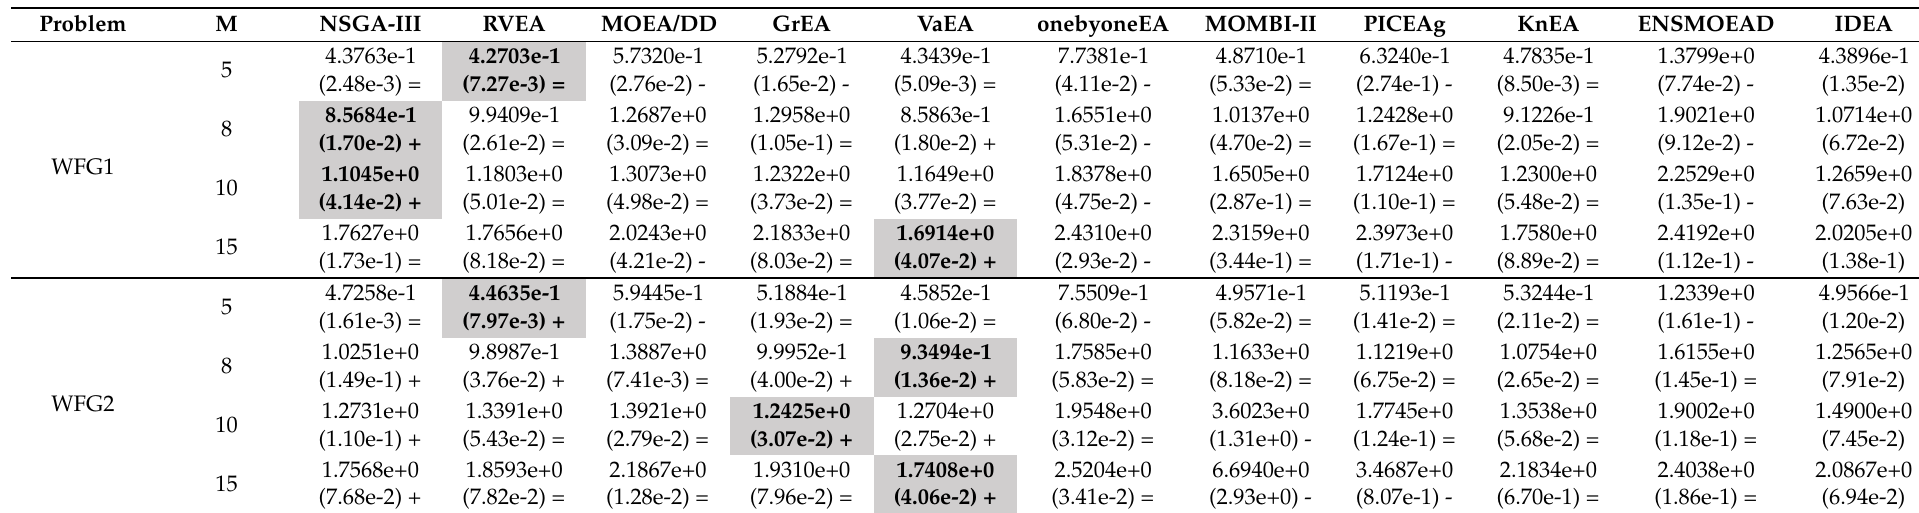
Table 5. The statistics of IGD results (mean and standard deviation ) on irregular Pareto front